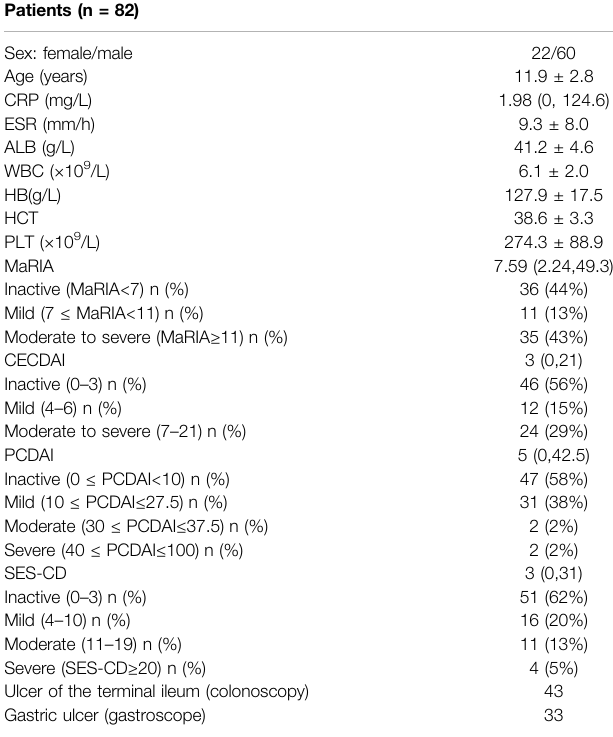
TABLE 1 | Demographic and clinical characteristics of the